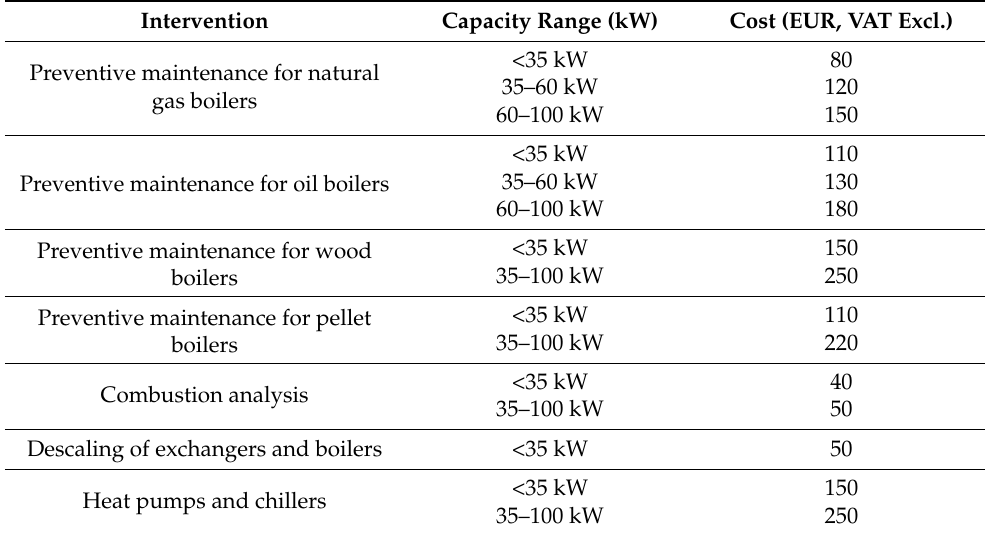
Table 5. Maintenance costs for boilers and heat